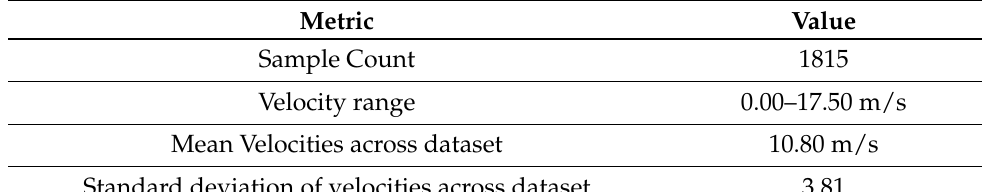
Table 3. Statistics of the